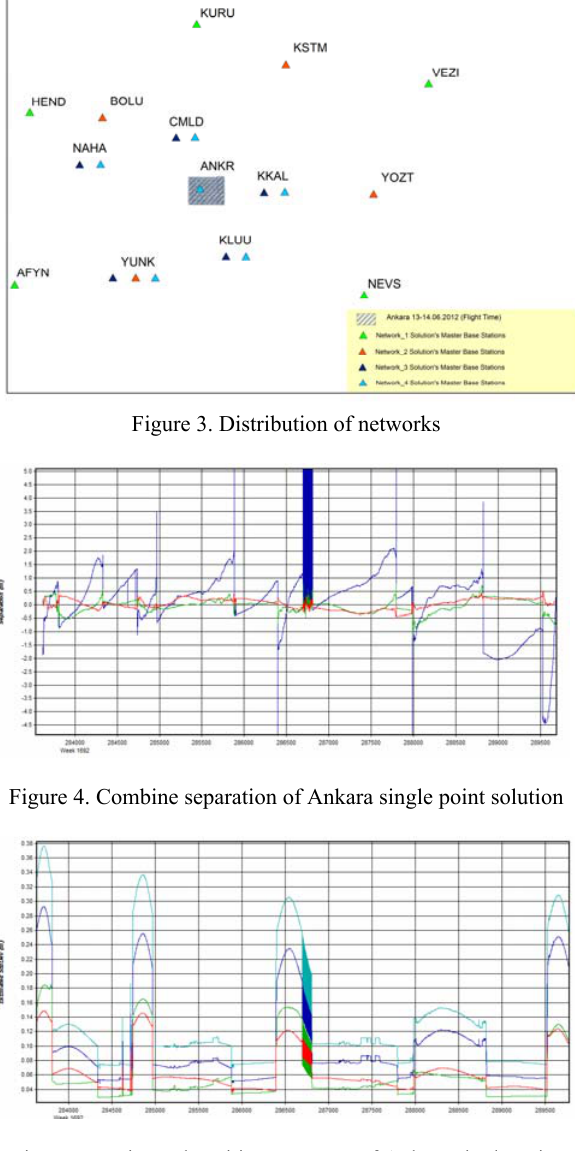
Figure 5. Estimated position accuracy of Ankara single point